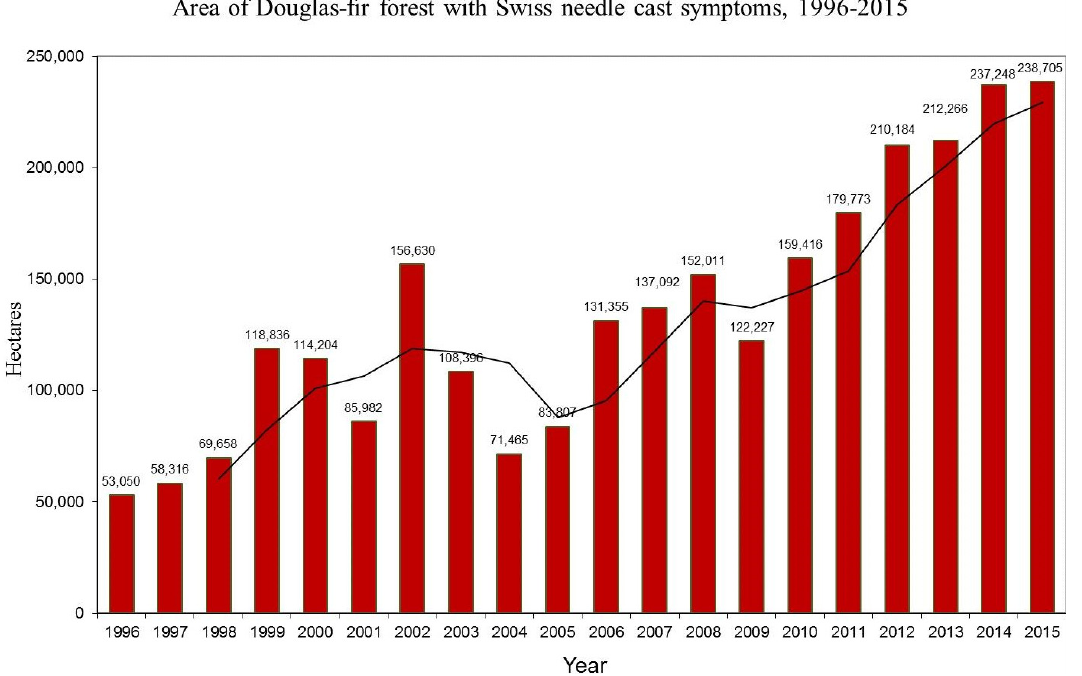
Figure 4. Area of Douglas-fir forests with Swiss needle cast symptoms determined from aerial survey in late spring from 1996 to 2015 (20 years).